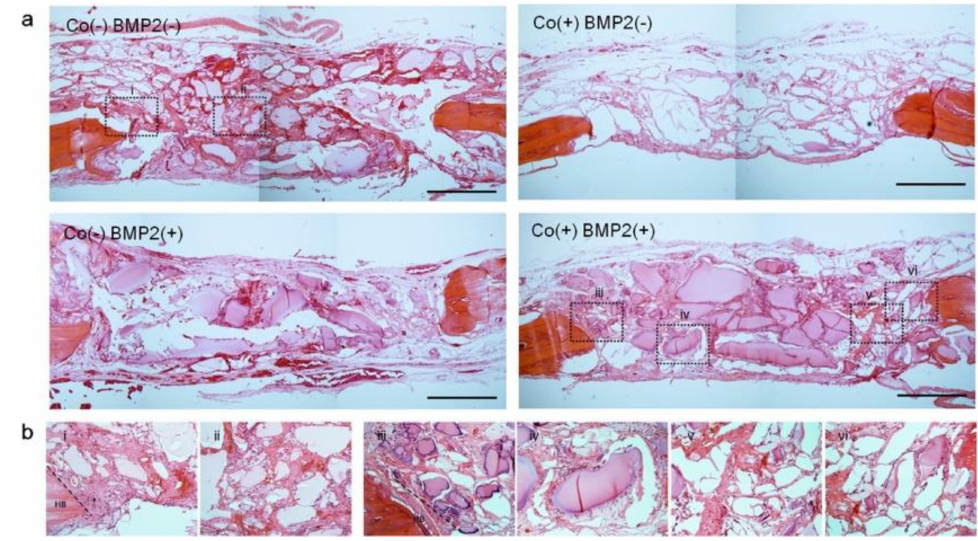
Figure 5. H&E stained sections of CAC implant in vivo after 6 weeks. ( a ) Low magnification image of CAC hydrogel groups including Co ( − ) BMP ( − ), Co (+) BMP ( − ) Co ( − ) BMP (+), and Co (+) BMP (+), ( b ) high magnification image of each groups. Reproduced from [89] with permission. Copyright (2015)